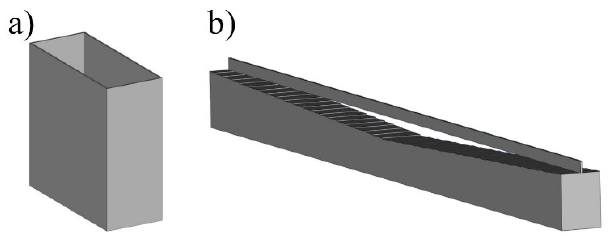
Figure 6. Specimen for the quantification of laser track width and penetration depth based on tin-like-structures. Structures consisting of a single laser track. ( a ) Width. ( b ) Depth.